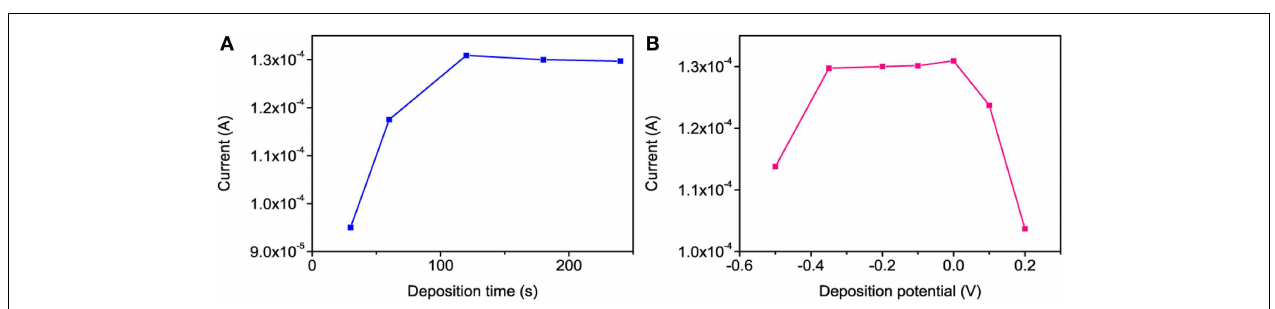
FIGURE 9 |The effect of (A) deposition time at − 0.3V vs.Ag/AgCl and (B) deposition potential for 120s on the DPSV stripping responses of 6 µ M of Hg 2 + at po-Gr/PEDOT:PSS-modified GCE in 0.05M HNO 3 .